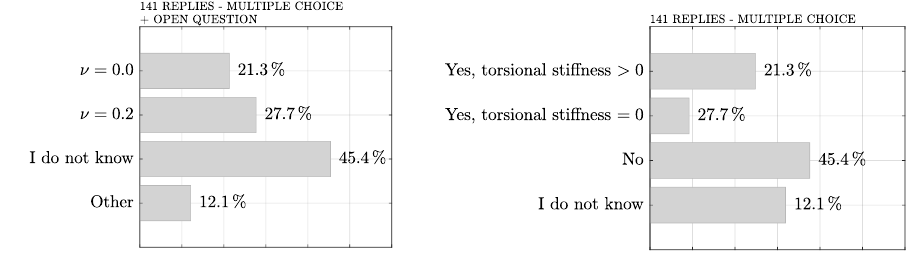
Figure 9. Applied Poisson’s ratio ( left ) and torsional stiffness ( right ).